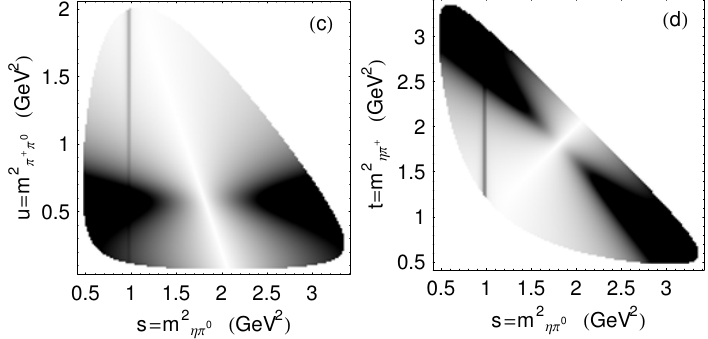
→ [ f → K ¯ K → a 0 Figure 7. The D + (980)] π + → ηπ 0 π + transition, caused by the a 0 0 (980) s 0 f 0 (980) mixing, manifests itself as the vertical bands in the Dalitz plot distributions for the D + → ηρ + → ηπ 0 π + with ηρ + in the intermediate events against the main mechanism D + s